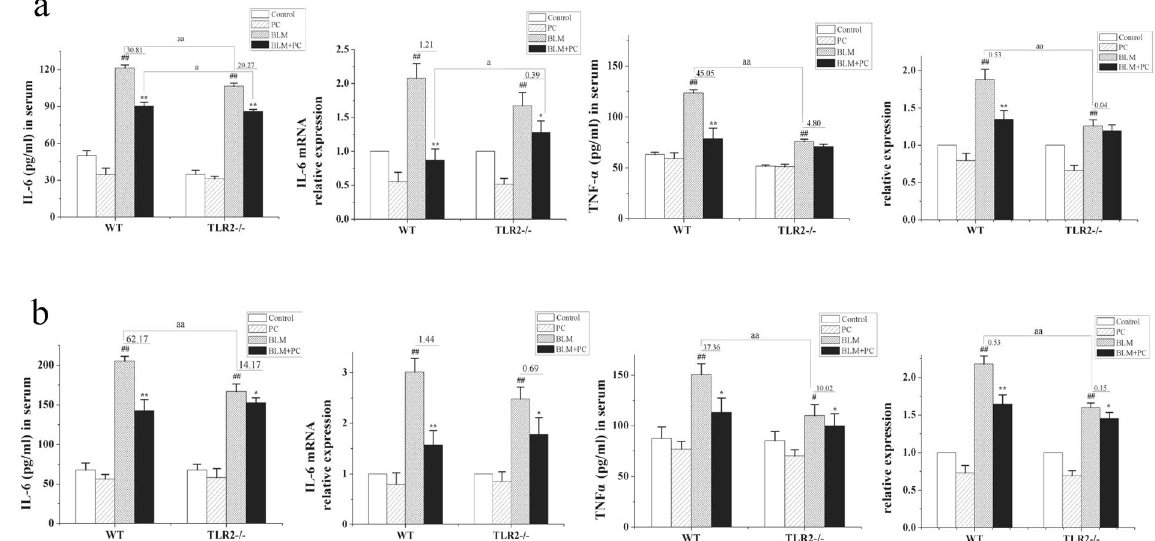
Figure 8. PC inhibits BLM-induced cytokines release. WT and TLR2 − / − mice were treated as described in the text. Mice were killed after BLM exposure at 3 day and 7 day. IL-6 and TNF- α levels in serum were measured through ELISA. mRNA levels were also observed in lung fibrosis. ( a ) 3 day. ( b ) 7 day. Data were expressed as mean ± SEM, (n = 6). ## p < 0.01 compared with the control group, ** p < 0.01 compared with the BLM group. aa p < 0.01 compared with WT